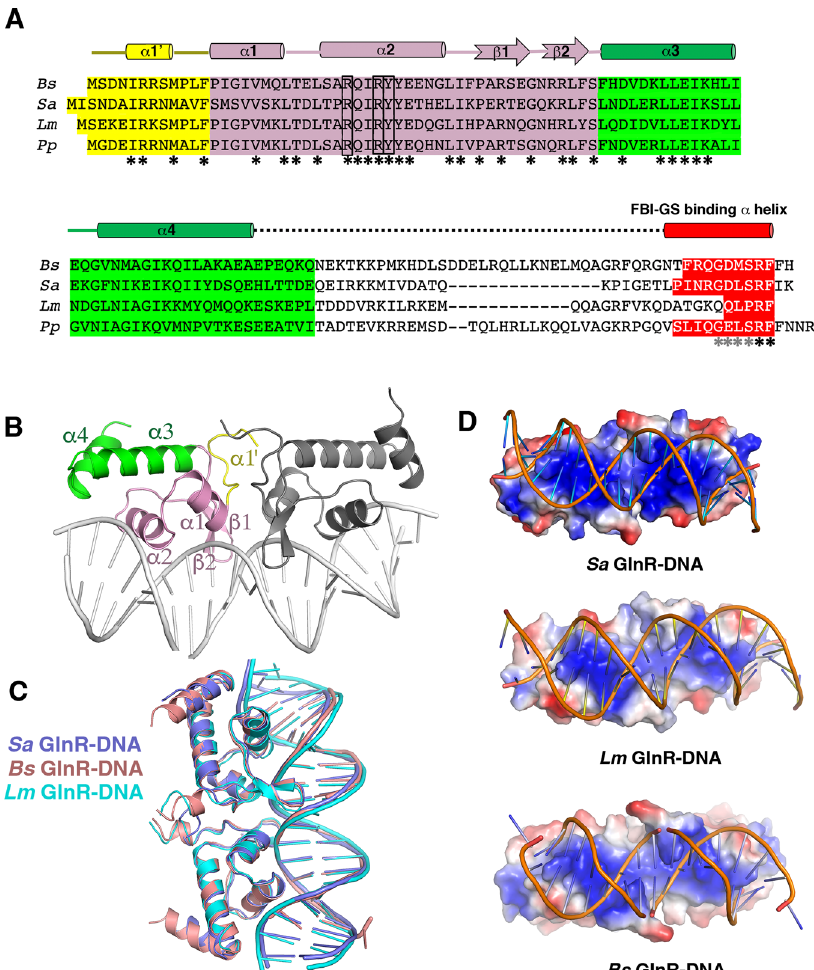
Fig. 7 GlnR – DNA structures. A Multiple sequence alignment of the Bs, Sa, Lm , and Pp GlnR proteins with secondary structural elements (from Bs, Sa , and Lm ) shown above the alignments. Residues in the N-terminal domains are highlighted in yellow, those in the wHTH are in pink and those in the C-terminal region are green. C-tail residues that bind FBI-GS are highlighted in red. Residues not observed in either the GlnR – DNA or FBI-GS-GlnR structures are not highlighted and form the fl exible linker connecting domains. Secondary structural elements are indicated over the sequence alignments. B Structure of the Sa GlnR – DNA complex, with one subunit colored as in A and the other colored gray. C Superimpositions of the Sa, Bs , and Lm GlnR – DNA complexes, which are colored slate, salmon and cyan, respectively. D Electrostatic surface diagrams of Sa, Bs , and Lm GlnR proteins bound to DNA. Blue and red represent electropositive and electronegative surfaces, respectively. The fi gure was generated as a charged smoothed potential in PyMOL ( Sa GlnR-DNA charge potentials levels range from − 86 to + 86, Bs GlnR-DNA from − 73.7 to + 73.7, and the Lm GlnR-DNA from − 81.3 to +